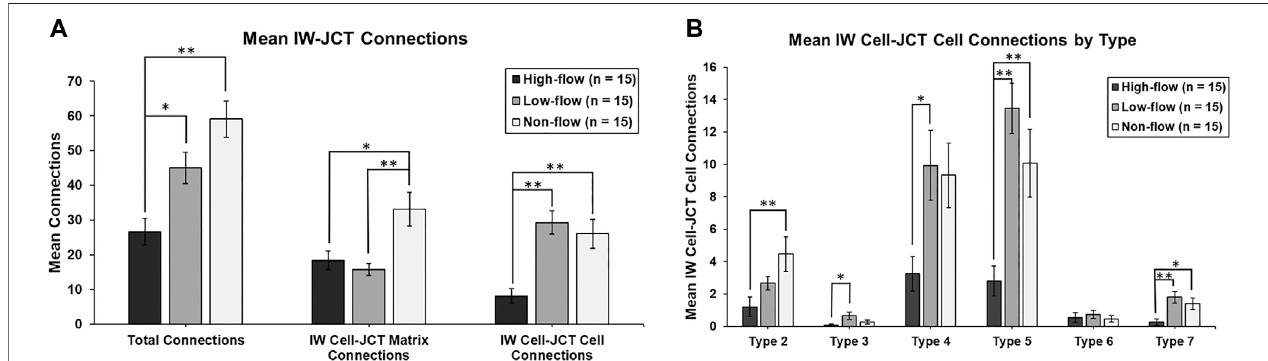
FIGURE 7 | Mean number of cellular connections between IW cells and JCT cells/matrix. (A) : Total connections were signi fi cantly decreased in cells in high- fl ow areas, compared to those in low- and non- fl ow areas. When analyzed by IW cell to JCT matrix (cell-matrix connections), IW cells in high- fl ow and low- fl ow areas had signi fi cantly fewer connections than those in non- fl ow areas. When analyzed by IW cell to JCT cells (cell-cell connections), IW cells in high- fl ow areas had signi fi cantly fewer connections than those in low- and non- fl ow areas. (B) : When IW cell-JCT cell connections were analyzed by type, the most common types were type 5, 4, and then 2. IW cells in high- fl ow areas had signi fi cantly fewer connections than cells in low- fl ow, non- fl ow, or both for all types, except type 6. Speci fi cally, for type 2, IW cellsinhigh- fl owareashadsigni fi cantlyfewer connections thanIWcellsinnon- fl owareas.Fortype 3,IWcellsinhigh- fl owareashadsigni fi cantlyfewerconnectionsthan IW cellsinlow- fl owareas.Fortype4, IWcellsinhigh- fl owareas hadsigni fi cantlyfewer connections than IWcellsinlow- fl owareas.Fortype 5,IWcells inhigh- fl owareas had signi fi cantly fewer connections than IW cells in low- and non- fl ow areas. For type 7, IW cells in high- fl ow areas had signi fi cantly fewer connections compared to IW cells in low- and non- fl ow areas. * p < 0.05; ** p ≤ 0.01. Error bars : SEM.